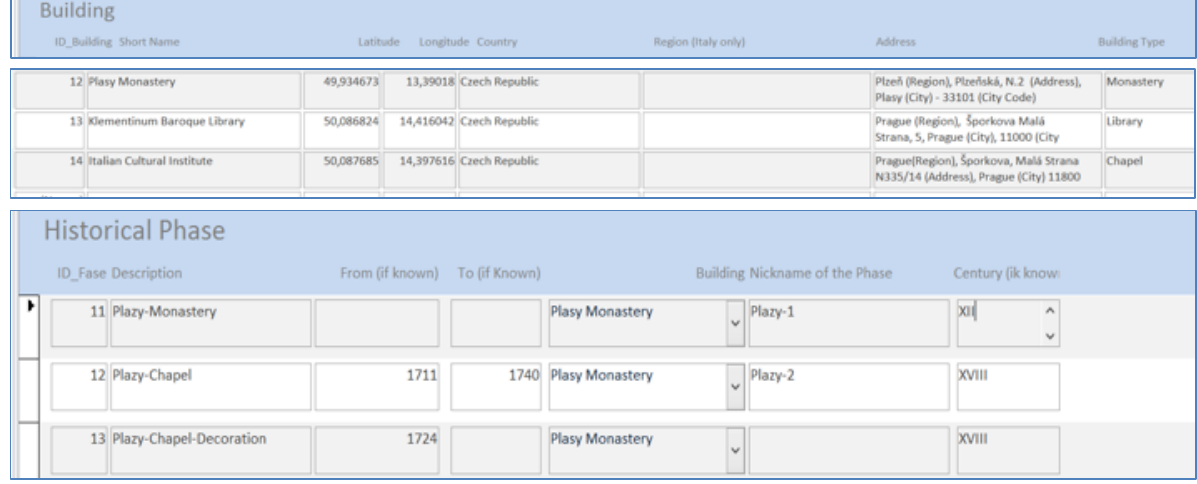
Figure 10. The Geo Database gathering the information acquired on the vaulted systems. In this case the Plasy Monastery Chapel star vault, together with the ones already processed (Klementinum Baroque Library and Italian Cultural Institute, both in